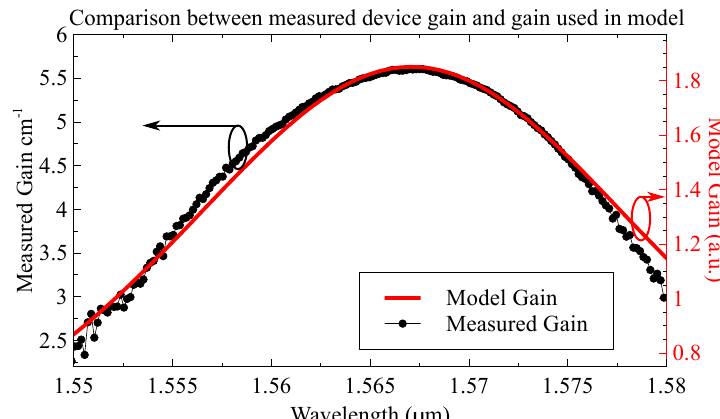
Figure 2. Comparison between measured device gain (left vertical axis) from a Fabry–Pérot (FP) laser calculated using the Cassidy gain method [29] and the gain g m implemented in the model (right vertical